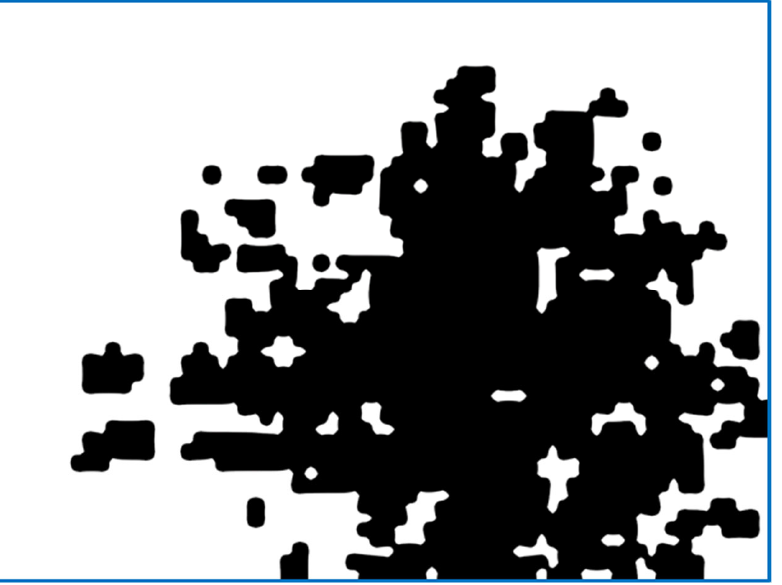
Figure 3. Functional scheme for image extraction features by algorithm of Figure 2.